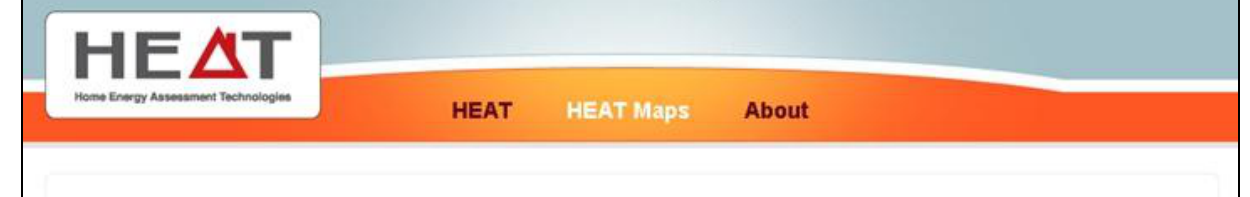
Figure 3. The HEAT Maps page illustrates (A) an image of the city, (B) the city HEAT Score, (C) City statistics, (D) Community statistics and (E) a smooth interpolated City Heat Map that models the overall residential waste-heat distribution within the